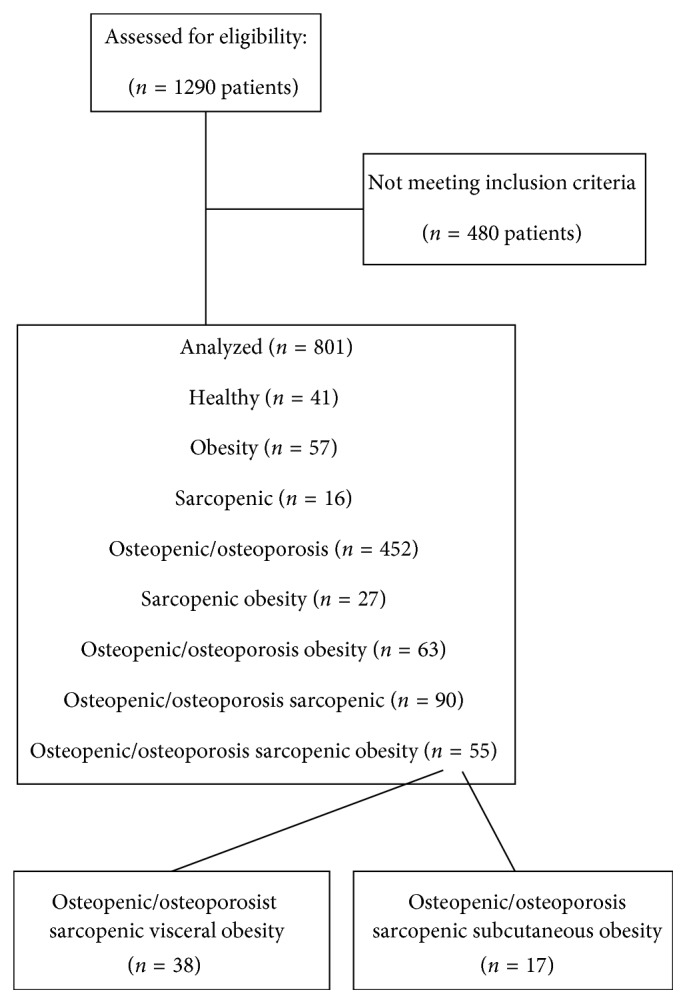
Flow diagram of the study.